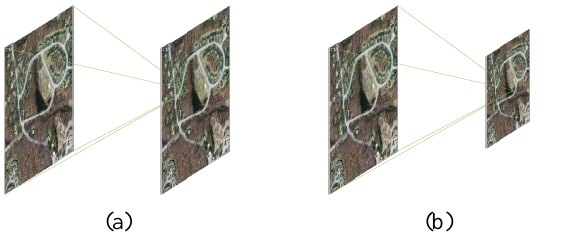
Figure 1. The attention feature maps. ( a ) The traditional non-local method, where each feature point includes all the information in the current feature map. ( b ) The core idea of our proposed network. Each feature point of the small-scale feature map is aggregated from the context information of the large-scale feature